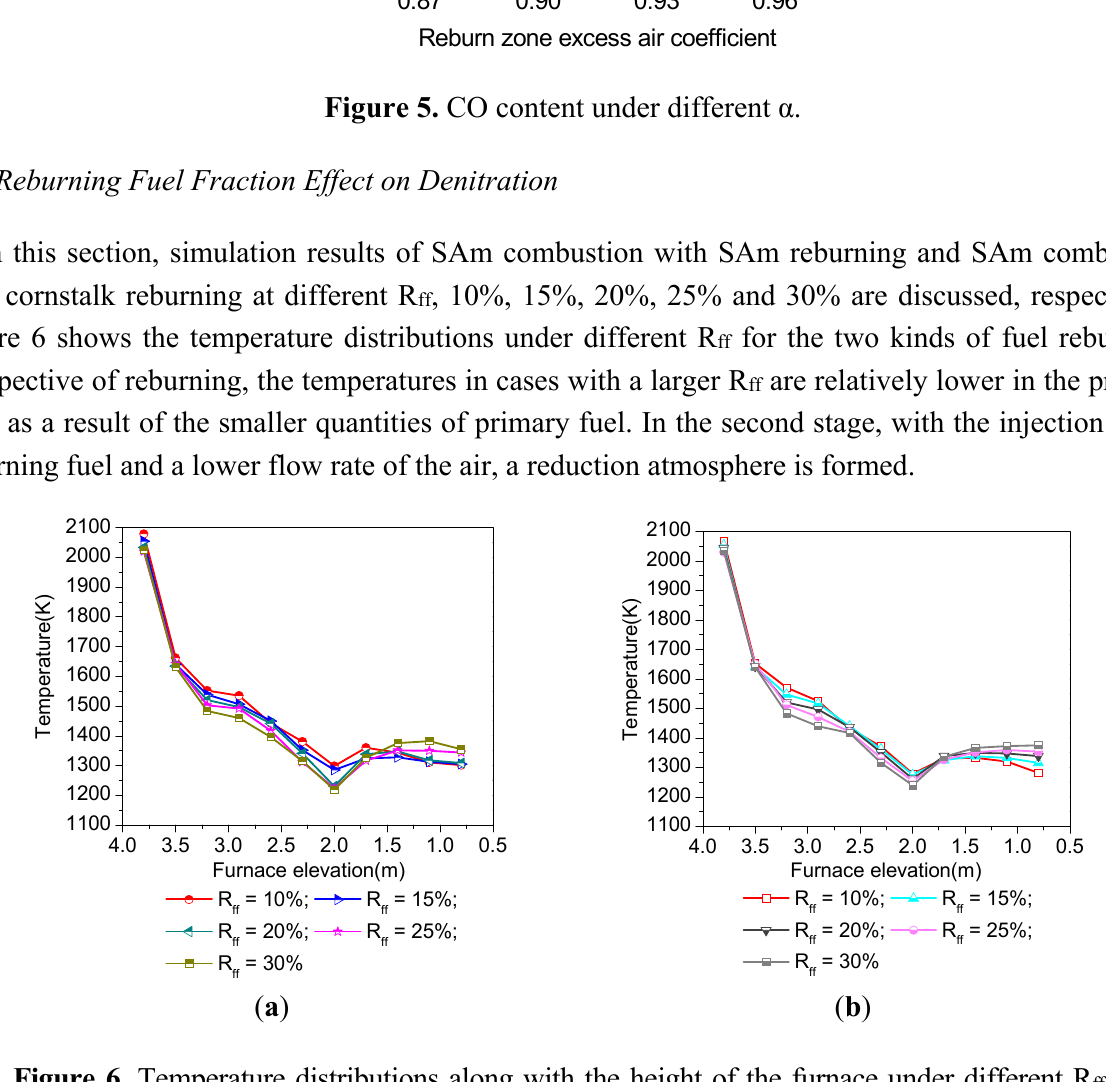
Figure 6. Temperature distributions along with the height of the furnace under different R ff : ( a ) SAm reburning; and ( b ) cornstalk